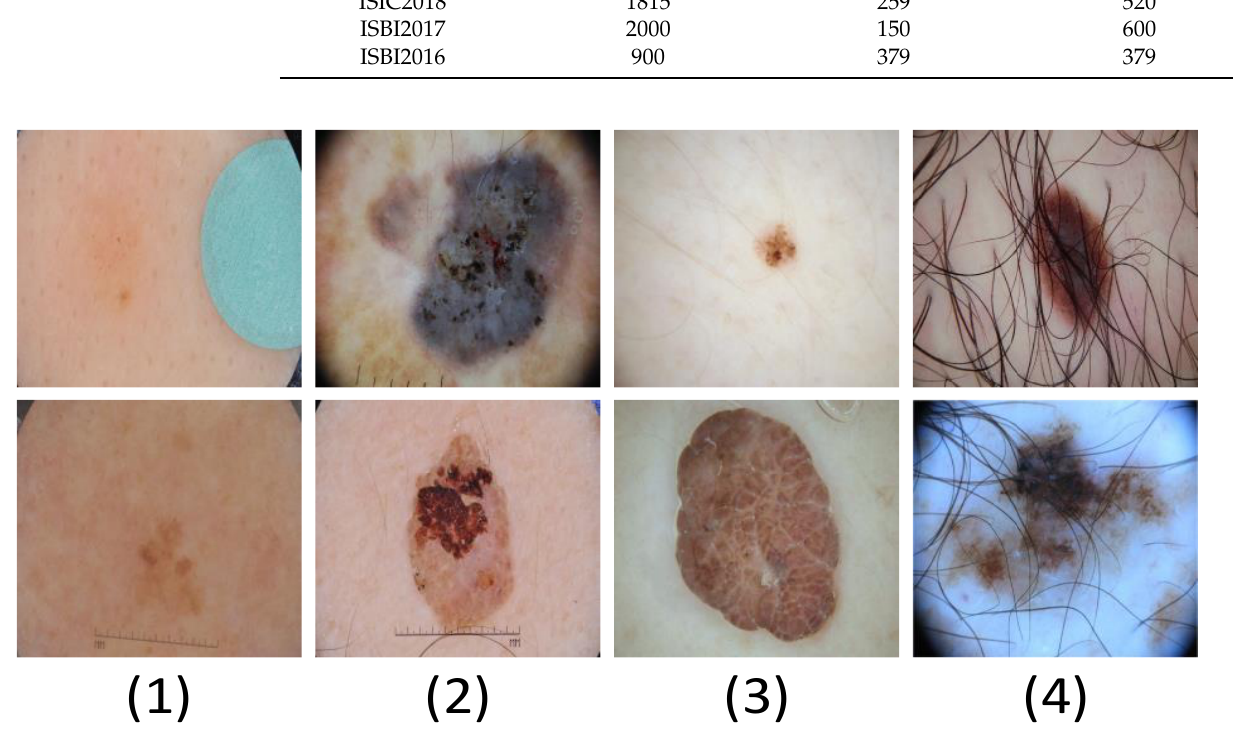
Figure 7. Challenges encountered in dermatological segmentation.